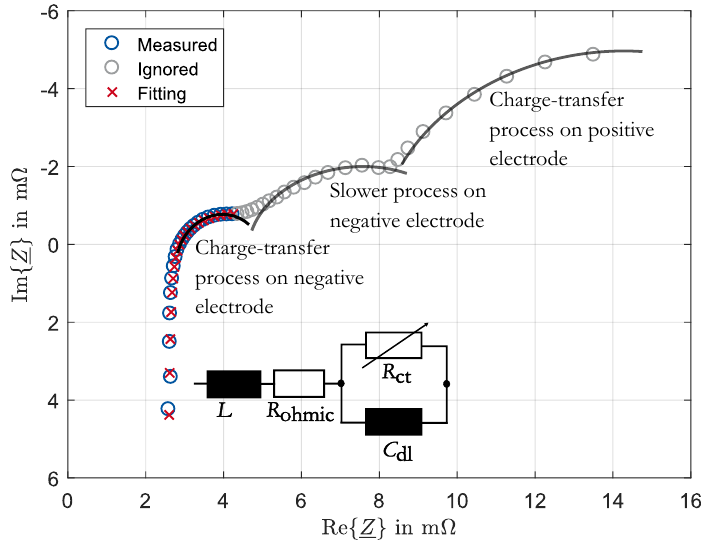
Figure 3. Nyquist diagram of a measured impedance spectrum with a superimposed DC-current of − 1.5I 20 in blue and the fitting result in red using the EEC shown in the